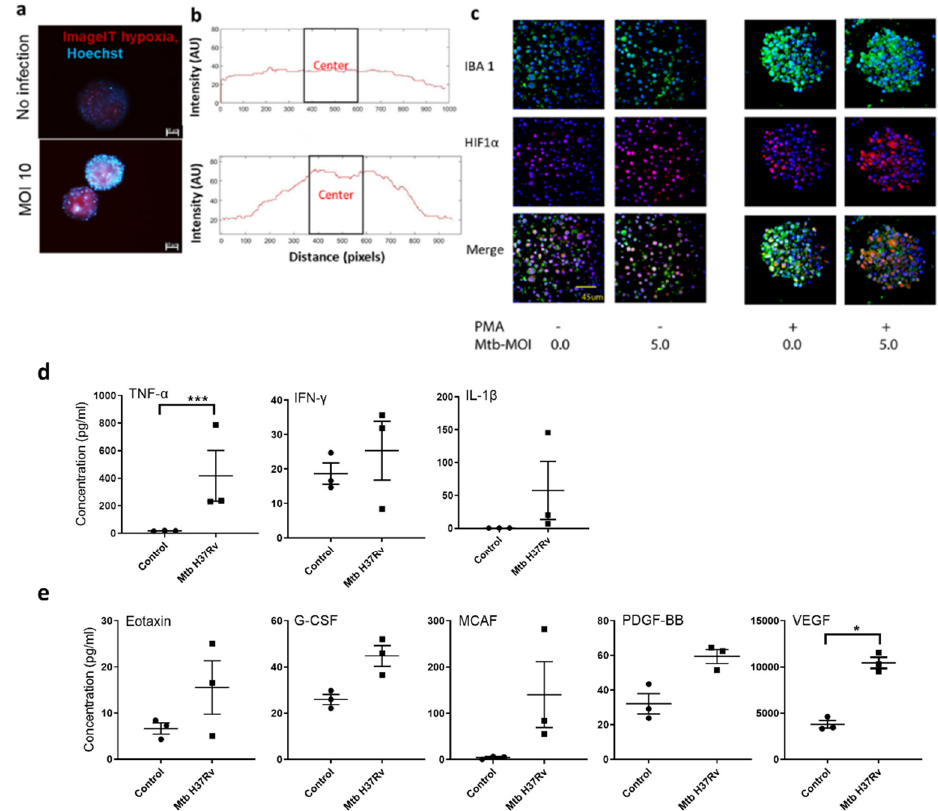
Figure 2. TB spheroids are hypoxic and pro-inflammatory ( a ) Fluorescent images of activated TB spheroid infected with BCG and cultured for 3 days. TB spheroids were stained with hypoxia probe (red) and Hoechst (blue). ( b ) The panels on the right show representative image of hypoxic probe intensity along the diameter of TB spheroid (size: 150–200 µ m), determined using MATLAB (Code is provided in Appendix A). For ( a , b ), images on top represent uninfected control groups, and the bottom represents TB spheroid infected with MOI 10 (BCG to macrophages). ( c ) Immunofluorescence-stained sections of activated (PMA) and non-activated TB spheroid infected with MtbH37Rv at MOI-5 and probed with antibodies specific to macrophages (IBA-1, green; top panel) or hypoxia-inducible factor (HIF-1a red; middle panel) imaged at a timepoint of 5 days post harvesting. The bottom panel shows the merged image. ( d , e ) Cytokine and growth factor profiles of Mtb H37Rv infected TB spheroid after 5 days in culture measured using multiplex cytokine analysis. Each dot in d and e represents the mean (average) value of an experiment with n = 3 wells per cytokine/growth factor estimation. Data presented are mean ± SEM of three experiments. (* p < 0.05; *** p < 0.005 when compared to non-infected controls, paired Student t -test).